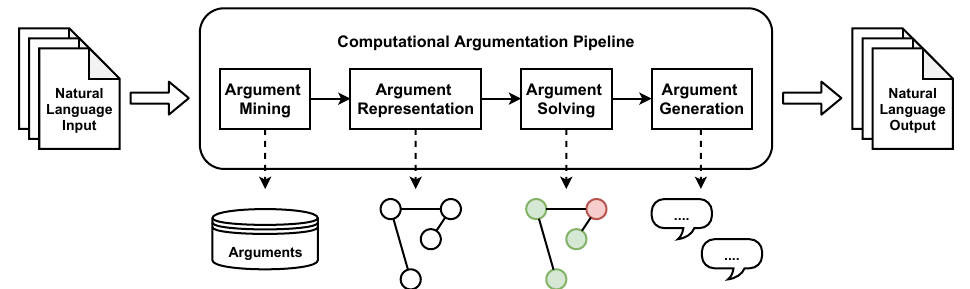
Figure 1. General pipeline for Computational Argumentation